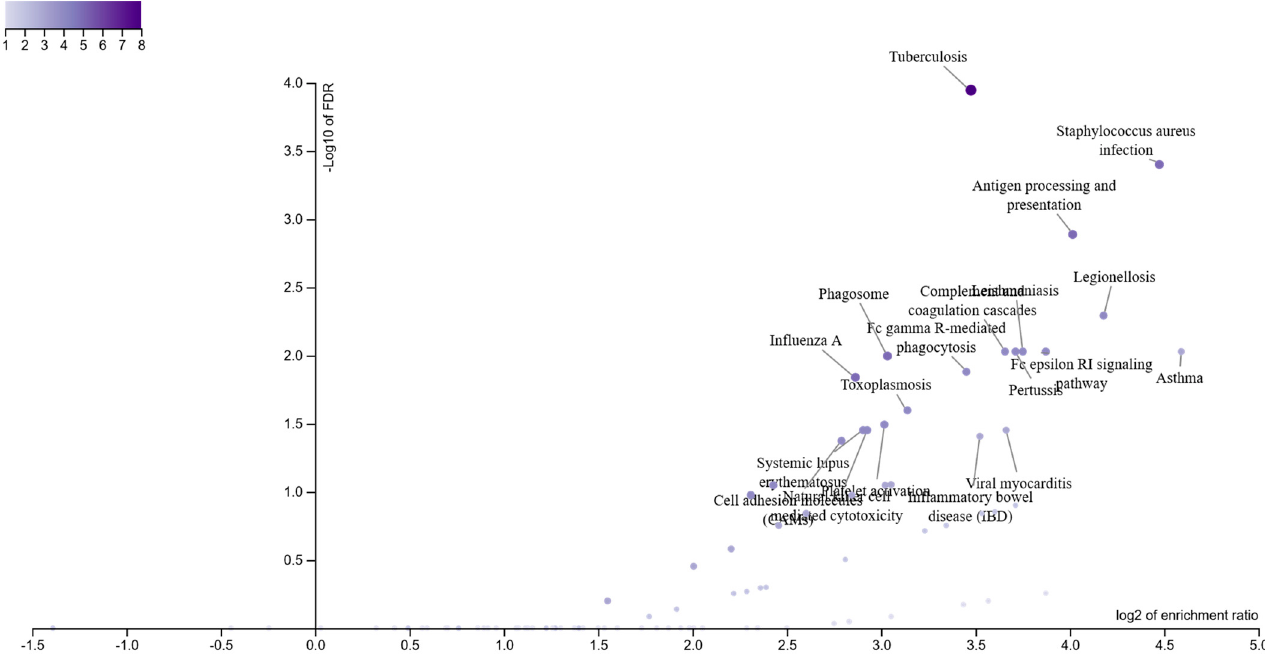
Figure 5. Biological interpretation of Module 7. Over-representation analysis (ORA) for the genes belonging to Module 7, performed using the KEGG database.